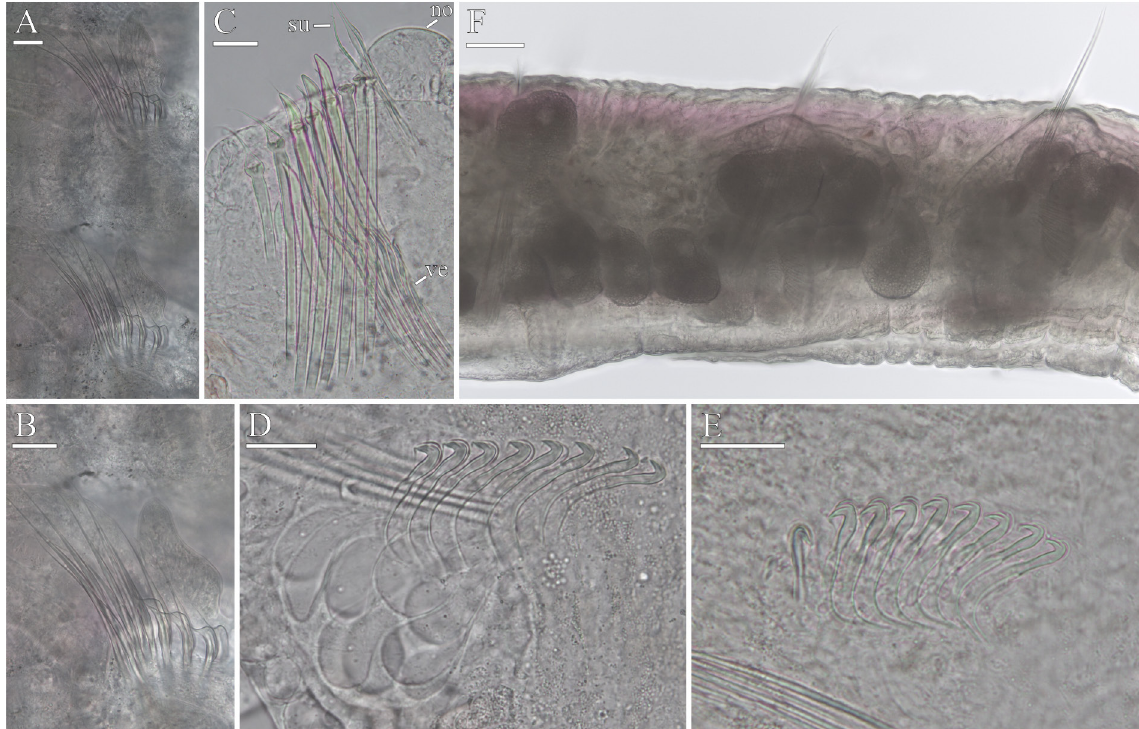
Fig. 15. Chaetal and gamete morphology of Pseudopolydora kuwaiti sp. nov. (live individuals, MIMB 40713). A . Notopodia of chaetigers 8 and 9, showing pennoned capillaries in the anterior row of notochaetae. B . Notopodium of chaetiger 10, showing pennoned capillaries in the anterior row of notochaetae. C . Chaetae of chaetiger 5. D . A series of hooded hooks and glandular pouch from fertile chaetigers, left lateral view, showing vitellogenic oocytes in ovaries. Abbreviations: no = notopodial postchaetal lamella; su = dorsal superior capillary chaetae; ve = ventral capillary chaetae. Scale bars: A–E = 20 µm; F = 50